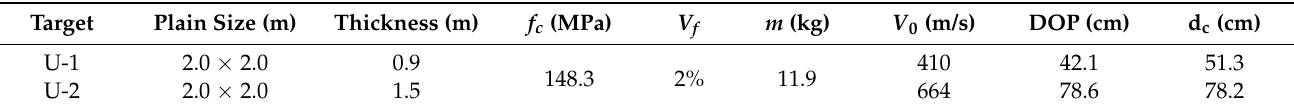
Figure 6. A certain moment in the penetration process. Table 1. Penetration tests data.